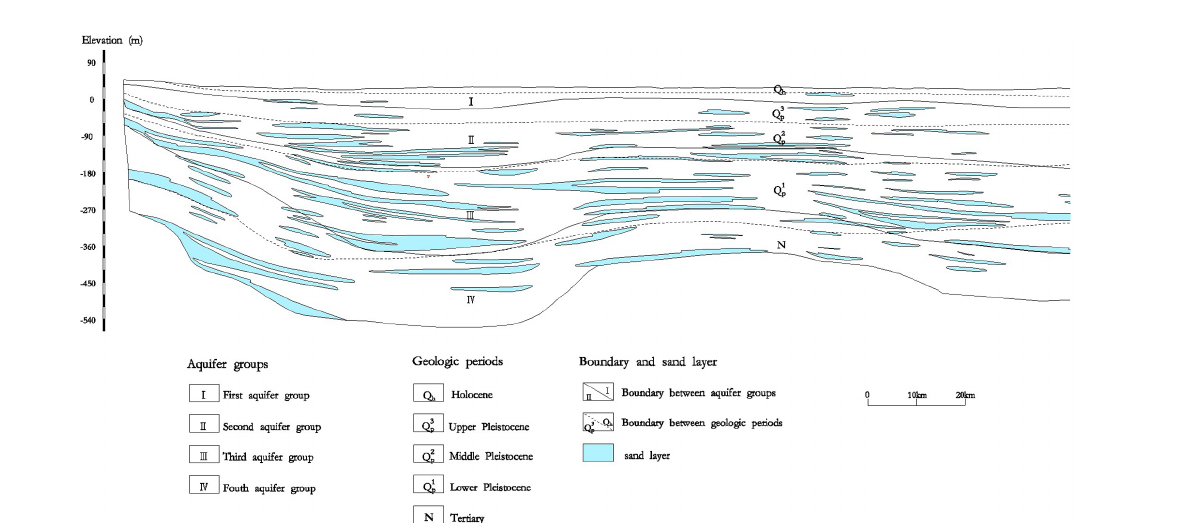
Figure 2. Hydrogeological cross section A-A’ (location shown in Fig.